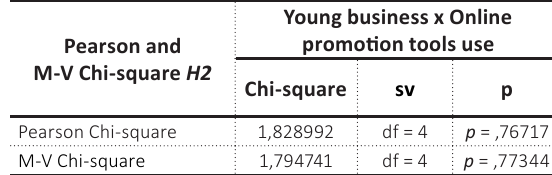
Table 3. Young business and Online promotion tools use